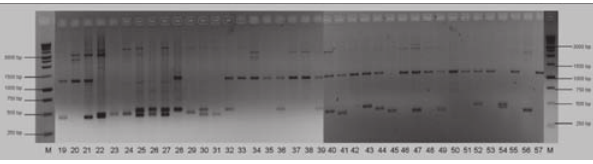
Figure 3. S-PCR analysis of 31 Turkish almond accessions from the village Bademli, Turkey, conducted using the EMPC2-consFD and EMPC3- consRD. M: 1kb marker (Promega), 1-31 the almond